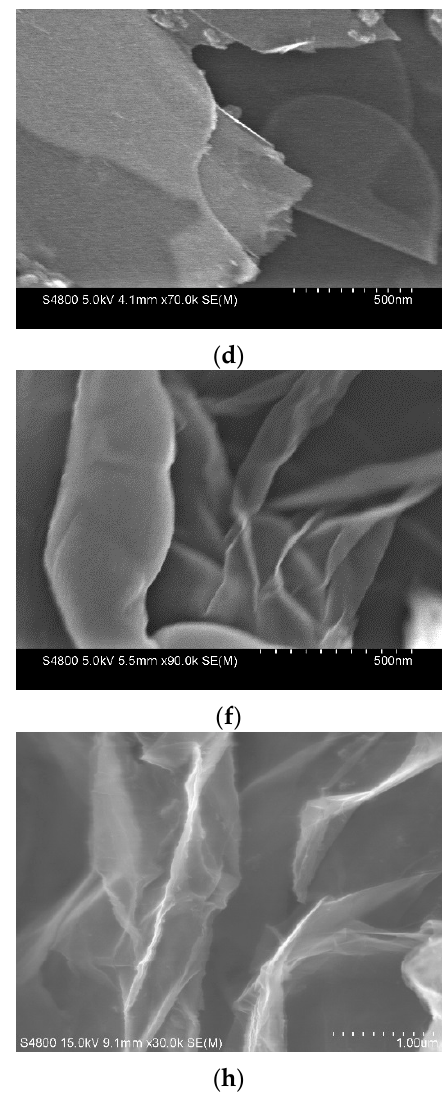
Figure 3. Typical SEM image ( a ) and higher-magnification SEM image ( b ) of Sample No. 1, SEM image ( c ) and higher-magnification SEM image ( d ) of Sample No. 2, SEM image ( e ) and higher-magnification SEM image ( f ) of Sample No. 3, SEM image ( g ) and higher-magnification SEM image ( h ) of Sample No. 4.